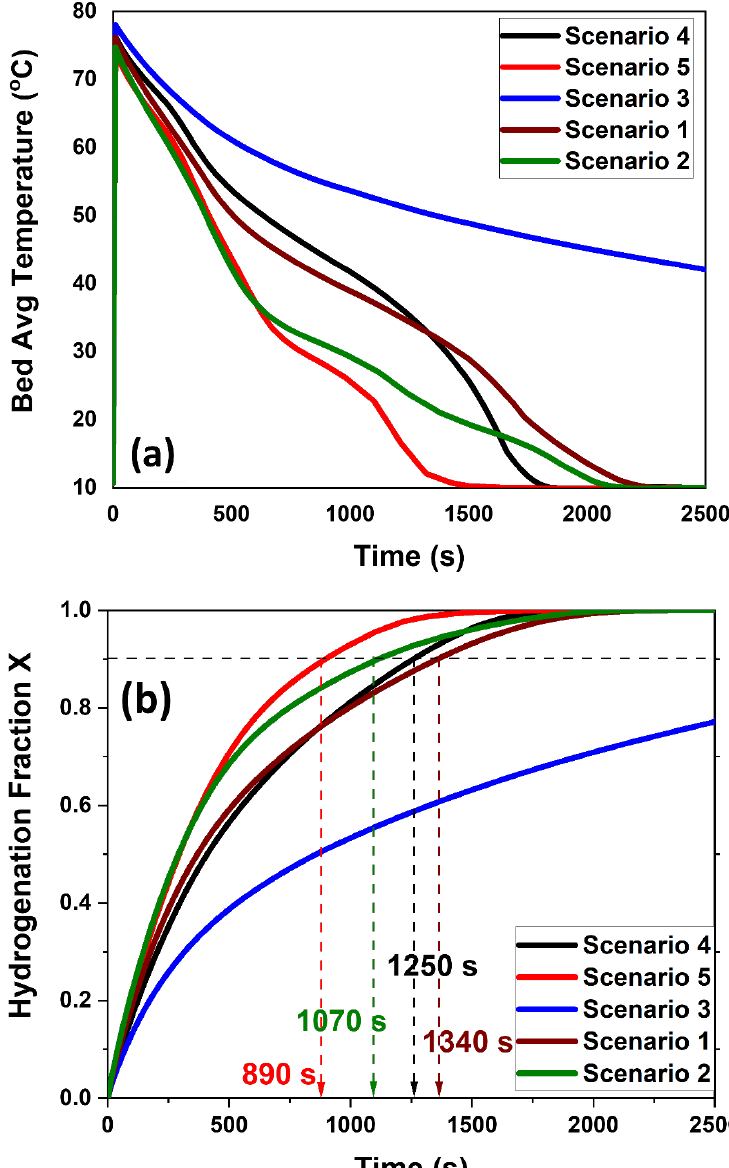
Table 3. Charging time of the materials studied for all the thermal management